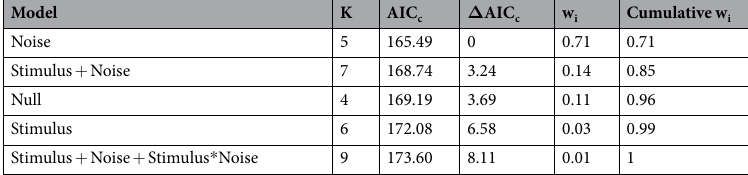
Table 3. AIC c model selection for post-playback approach distance.